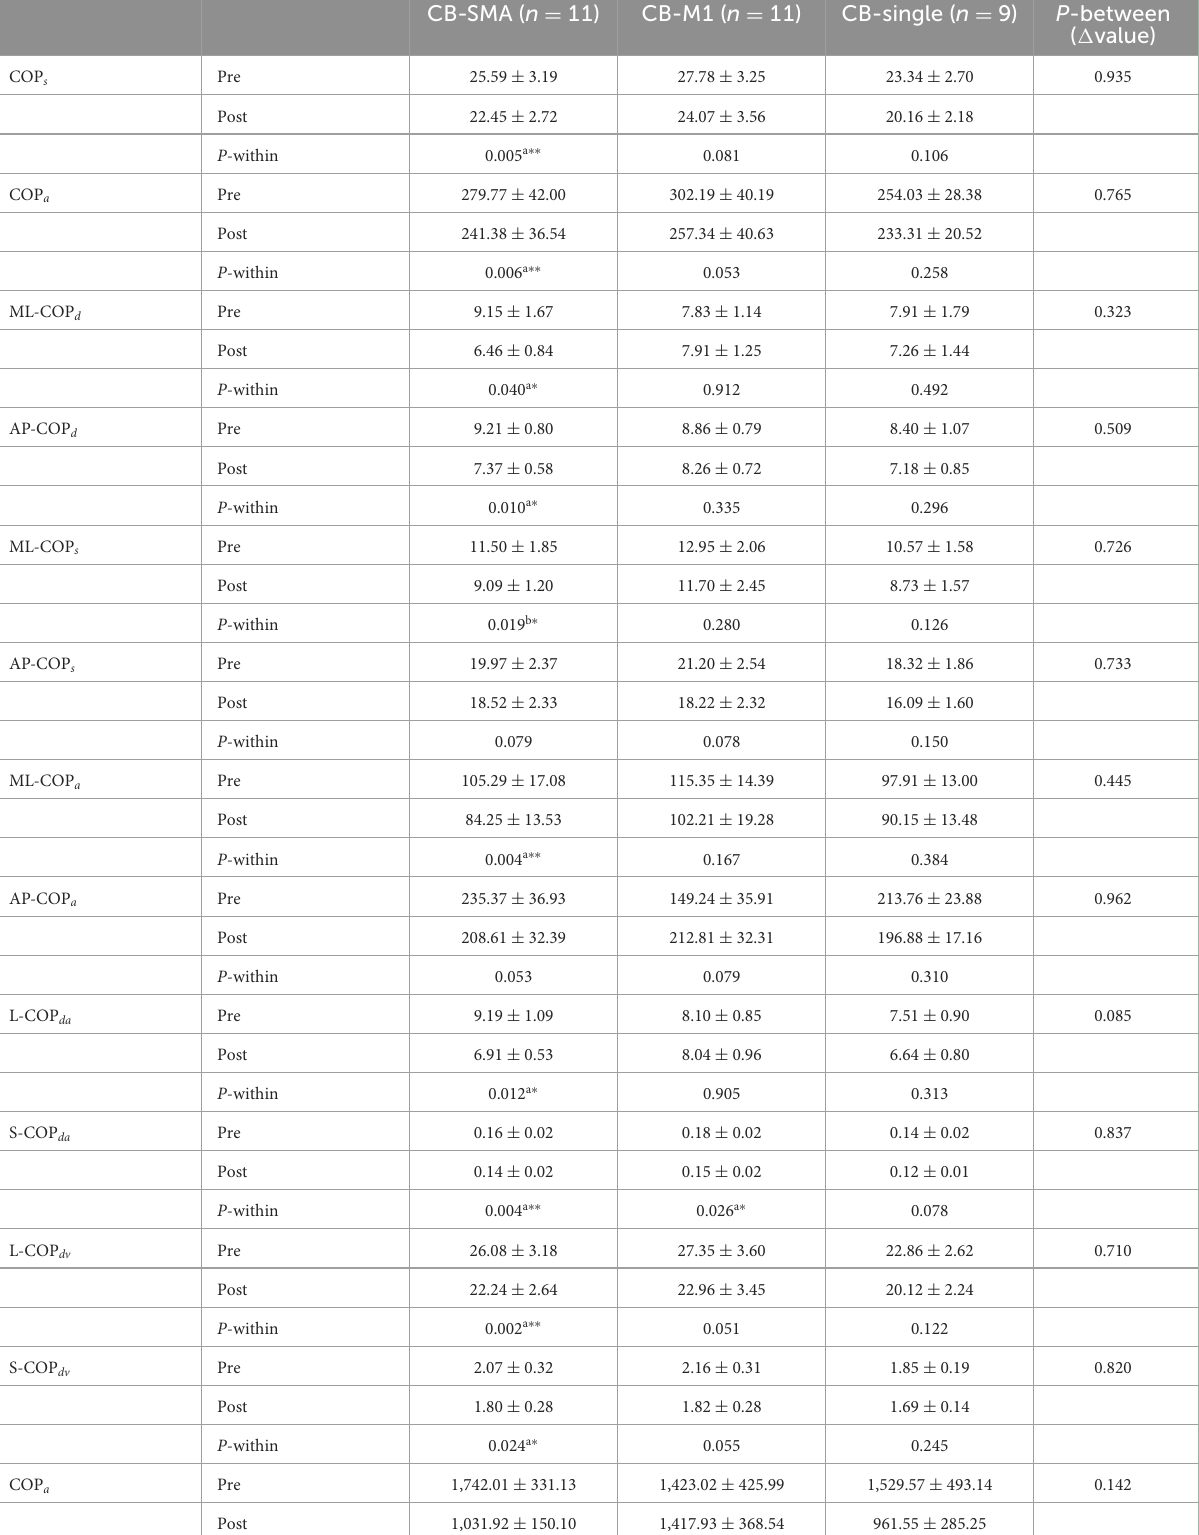
TABLE 4 Balance board parameters in eyes closed